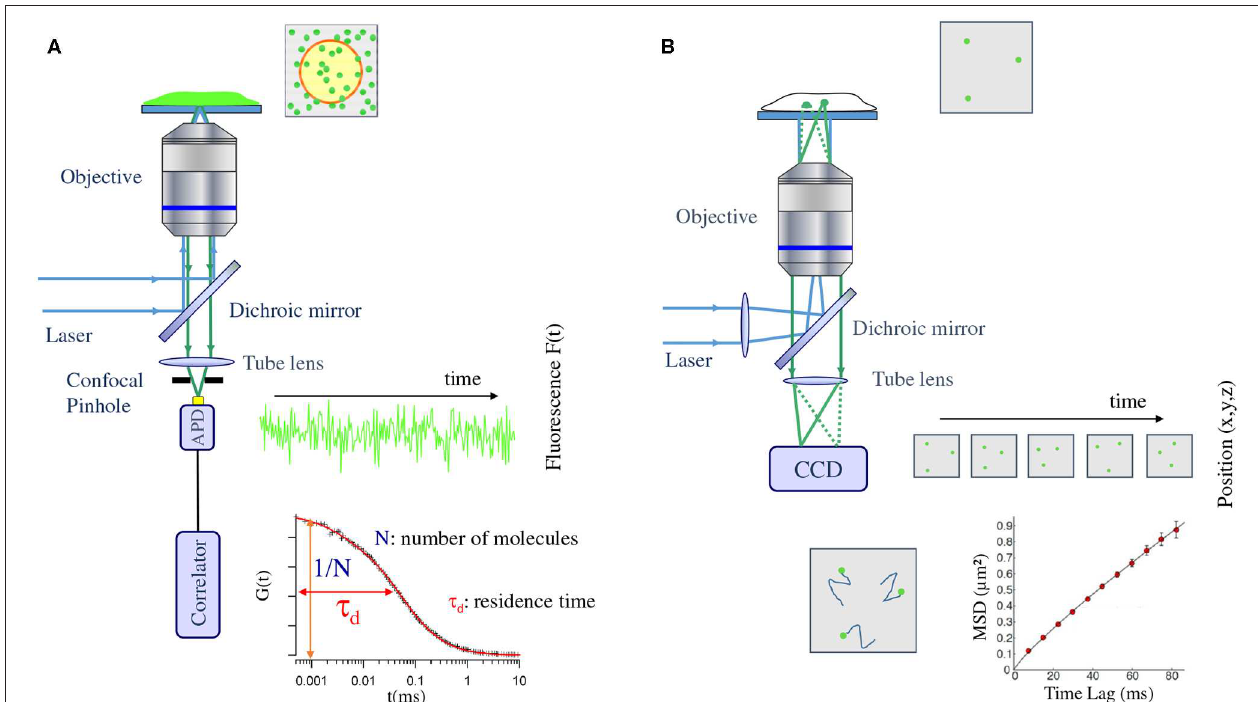
FIGURE 1 | Schematic view of the typical setup used in fluorescence correlation spectroscopy (A) and single/multiple particle tracking (B) experiments. (A) A laser is focused on the fluorescently labeled sample by the objective of a microscope. The fluorescence is then collected by the objective and focused in a confocal way (using a pinhole) on a single photon counting detector (avalanche photodiode, APD). This detector records the fluctuation of fluorescence emission within the confocal volume of the sample. A direct link to an electronic correlator authorize on line generation of the autocorrelogram. (B) A laser is focused at the back focal plane of a microscope objective in order to obtain a full field illumination of the sample. The fluorescence emitted by each single particle present in the illumination field is then directly imaged on a sensitive camera (Charge Coupled Device, CCD). A movie is obtained and the post processing of this movie allow tracking of the individual emitter and latter on, generation of Mean Square Displacement (MSD) as a function of lag time